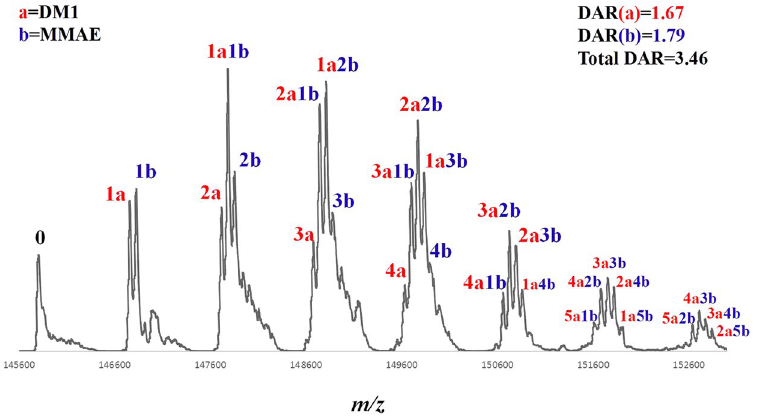
Figure 5. MS profile of dpADC 6 and DAR analysis (see detailed m/z assignment in supplementary data Table